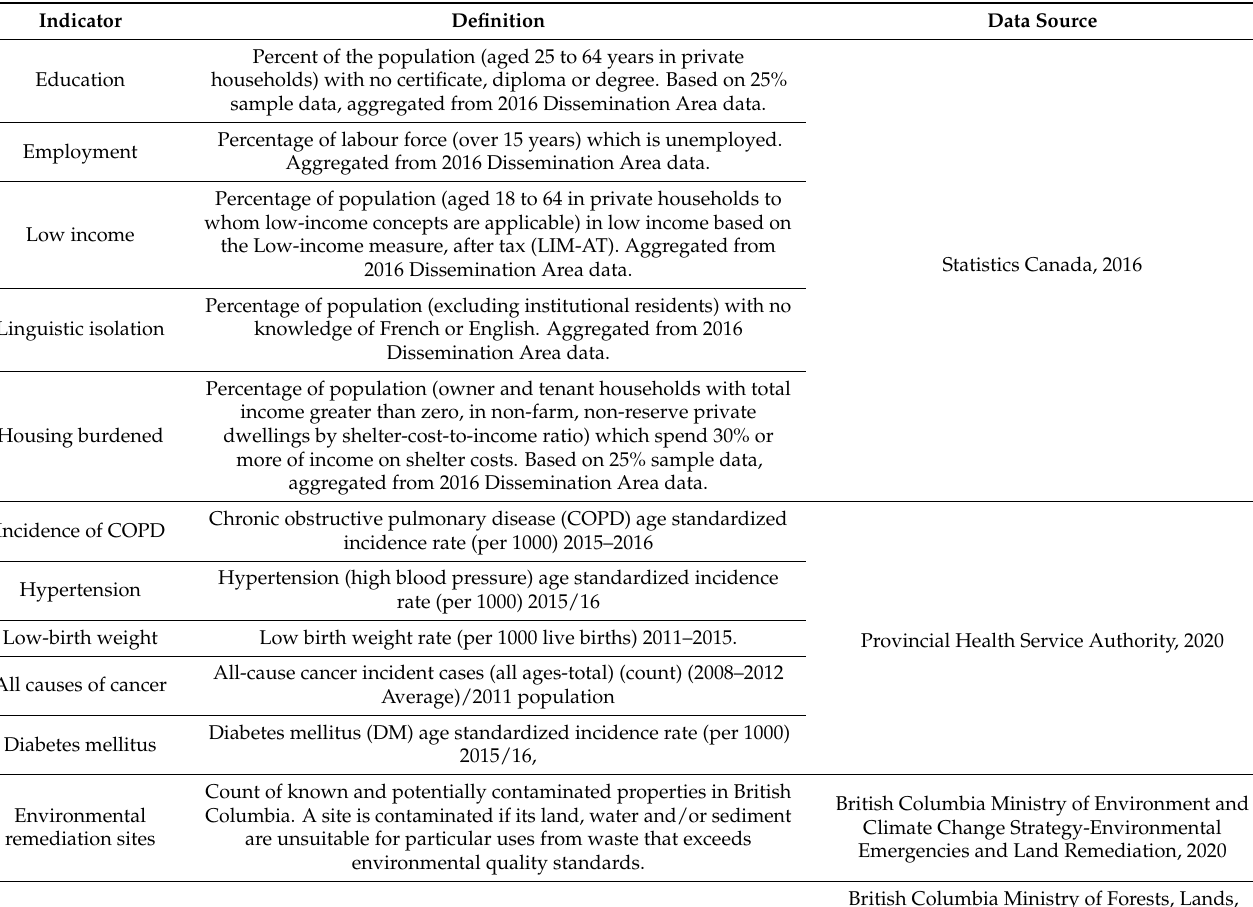
Table 1. Indicator definitions and data